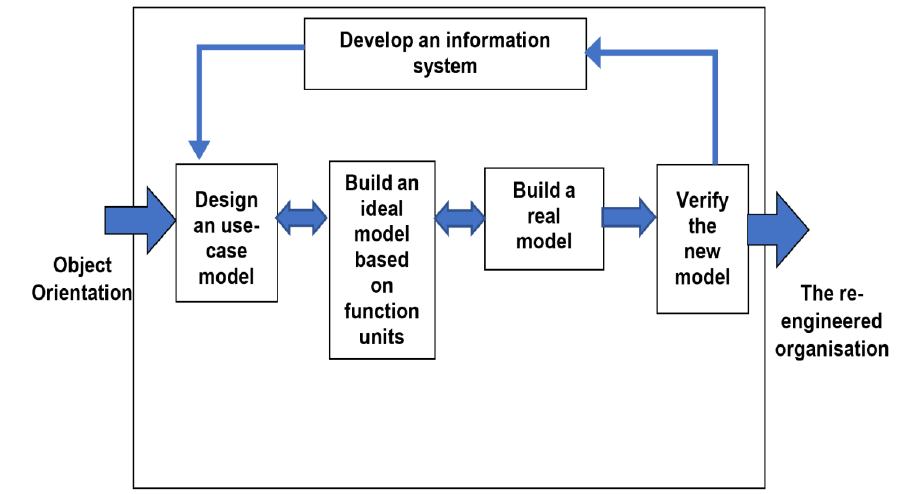
Figure 5. Forward engineering activities.